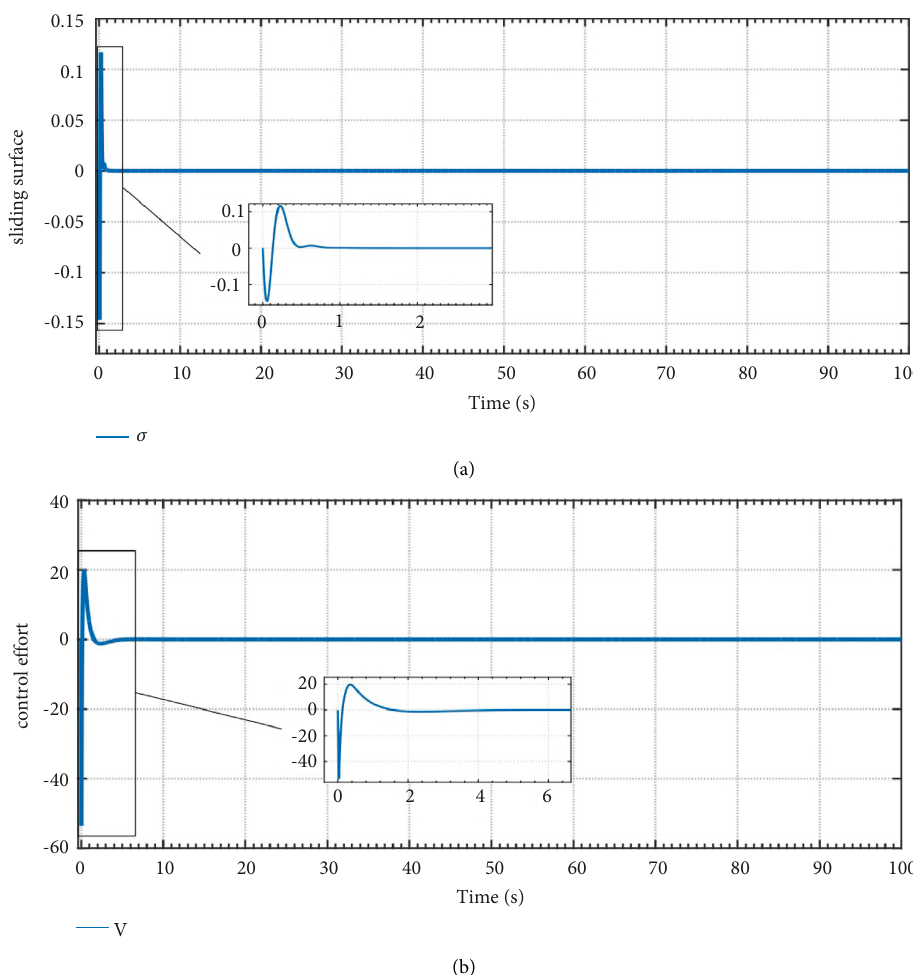
Figure 10: Antisynchronization of identical 4D hyperchaotic financial system with the adaptation of parameters. (a) Sliding manifold σ . (b) Control effort v